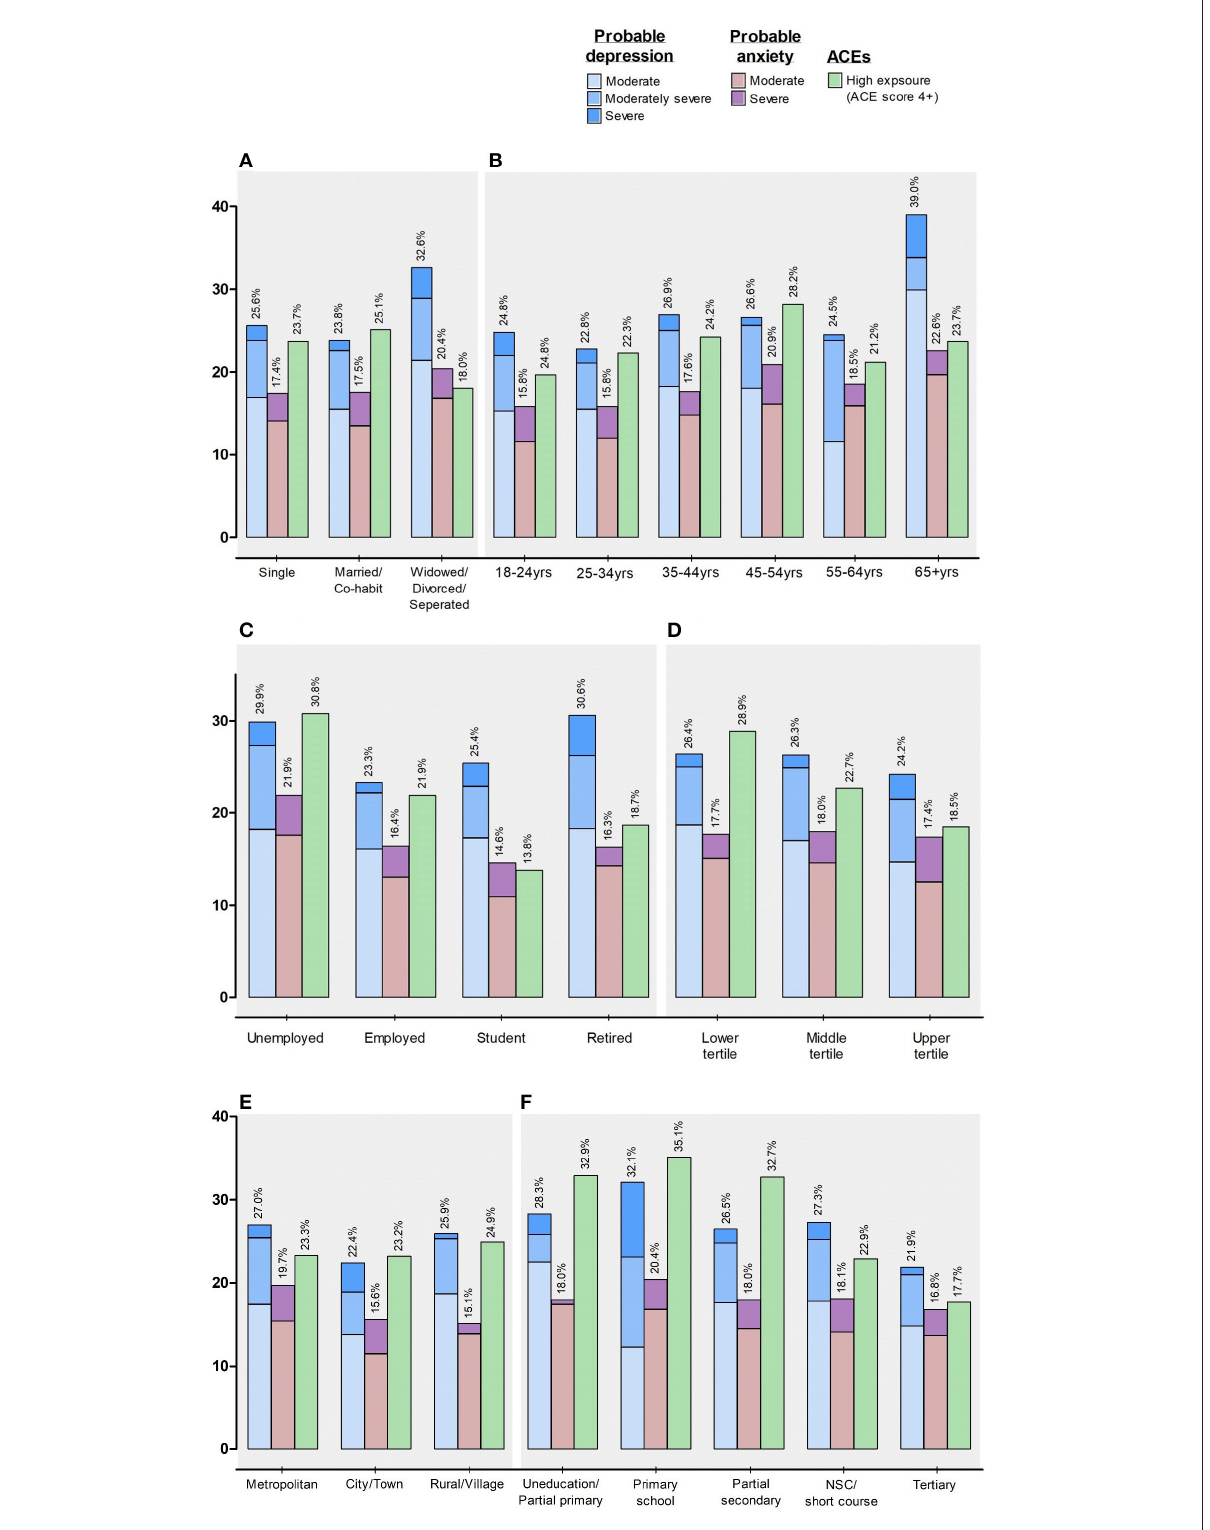
FIGURE4 Mental health risk stratified by (A) marital status; (B) age categories, (C) employment status, (D) household asset score, (E) urbanicity, and (F) education level. %, percentage; NSC, National Senior Certificate (Grade